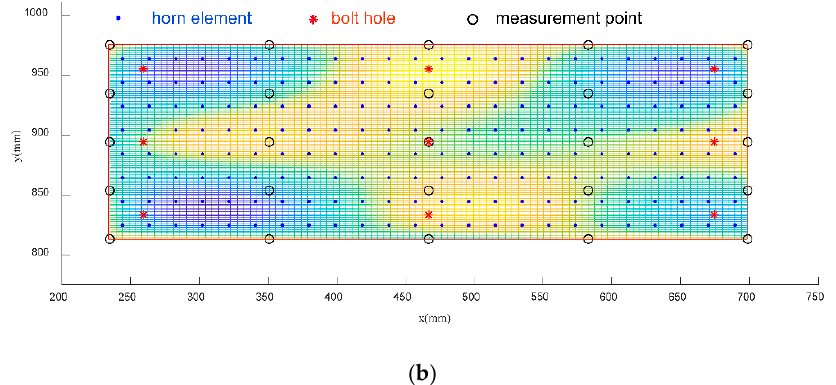
Figure 5. ( a ). The model of flatness. The blue points represent the discrete horn elements, the black points represent the measurement points, and the red points represent the bolt holes on the plate. The whole NURBS surface represents the realistic reflection plate, while the red rectangle borders define the tolerance zone of the flatness. ( b ). The top view of the flatness model.